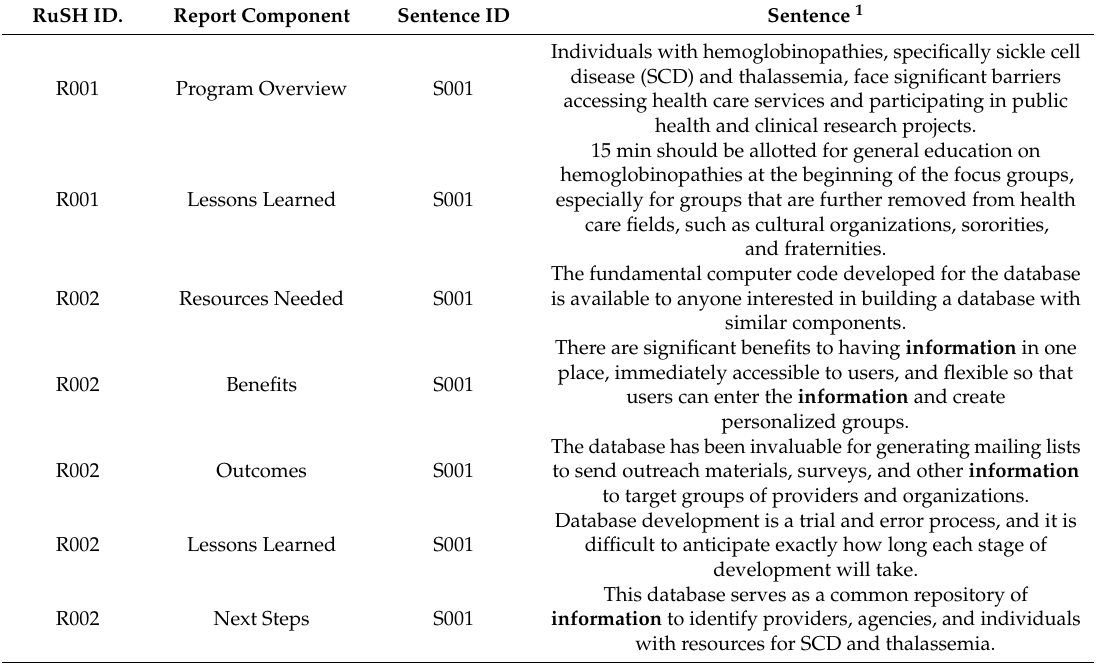
Table3. ExampleofsentencesinsectionsoftheRegistryandSurveillanceSystemforHemoglobinopathies (RuSH) Report. RuSH